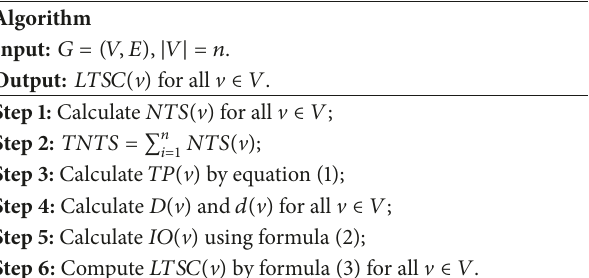
Table 1: Computing the node’s LTSC value. Algorithm